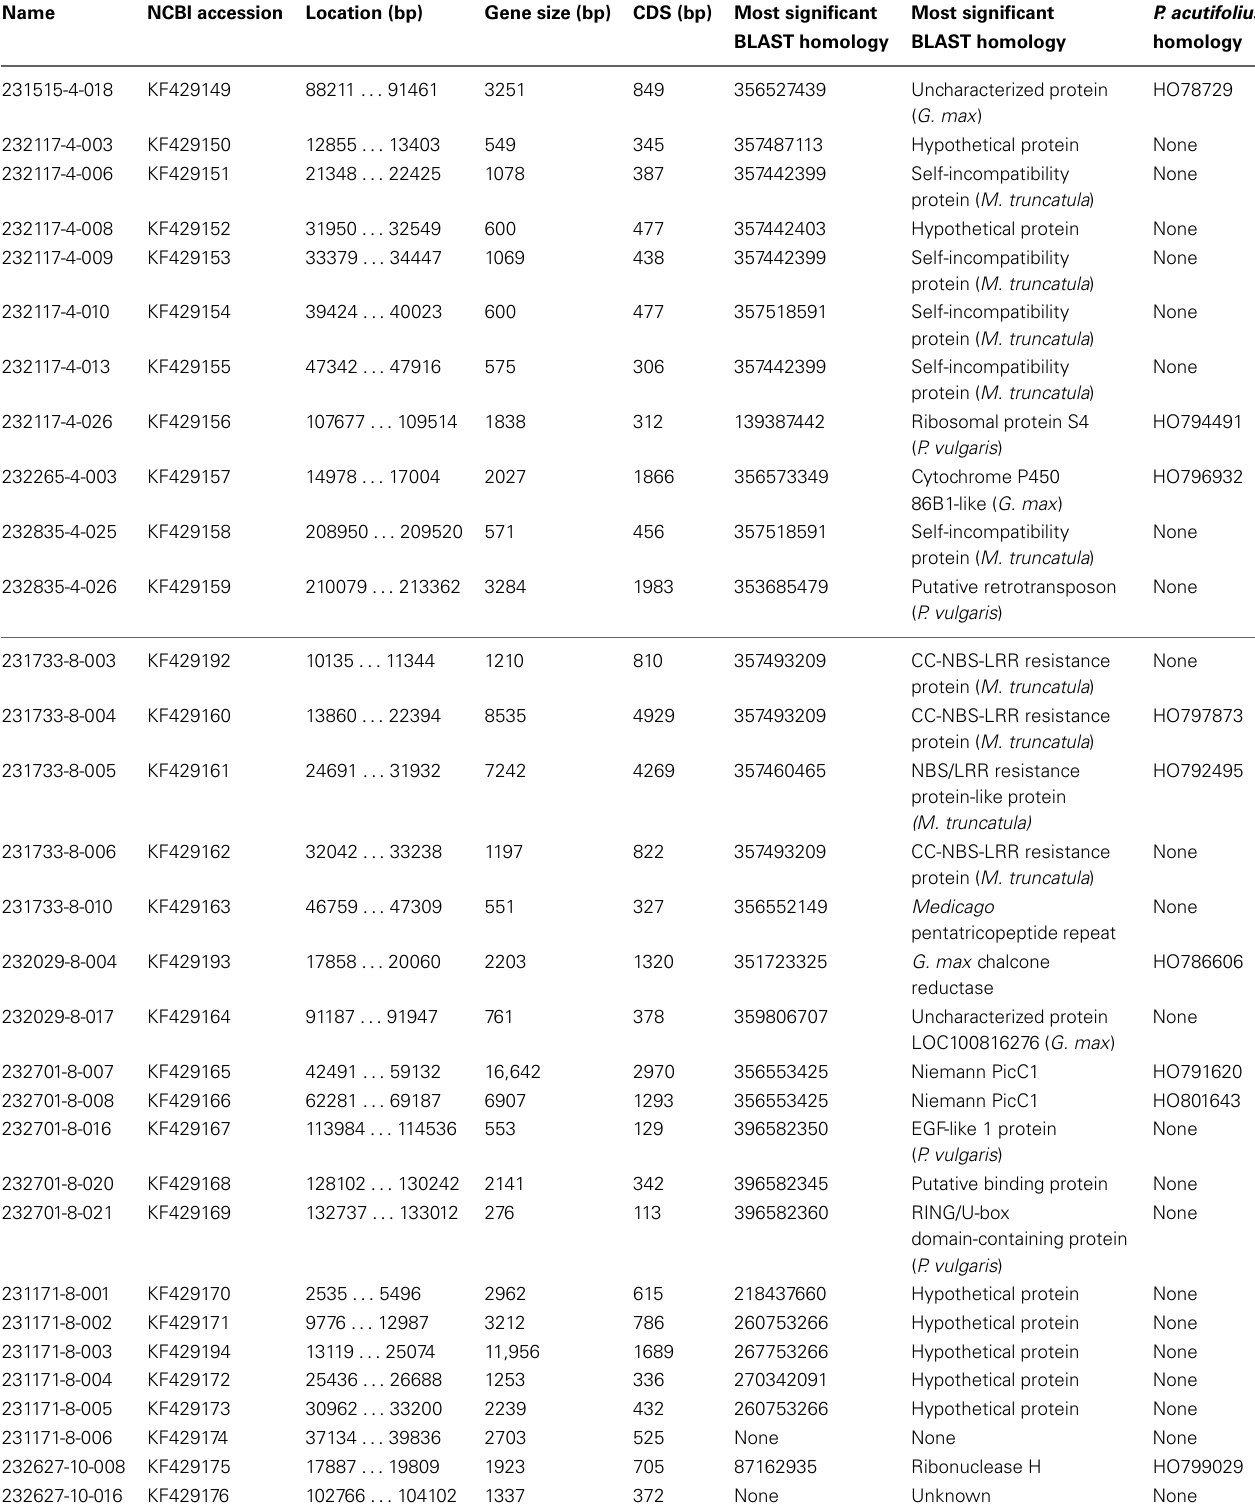
Table 2 | Unique genes identified in